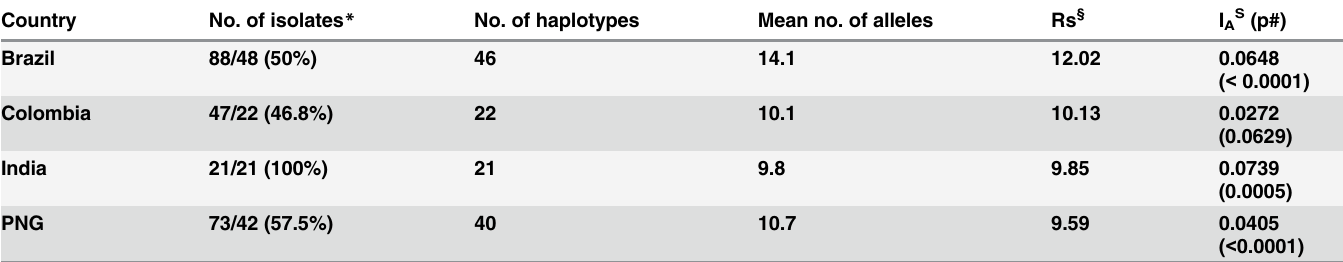
* Number of isolates genotyped for at least 1 MS / number of isolates fully genotyped at all 7 MS loci (%) § Rs mean is based on minimum sample size of 21 individuals # LD ( I S A ) is considered signi fi cant when p value is (cid:1)